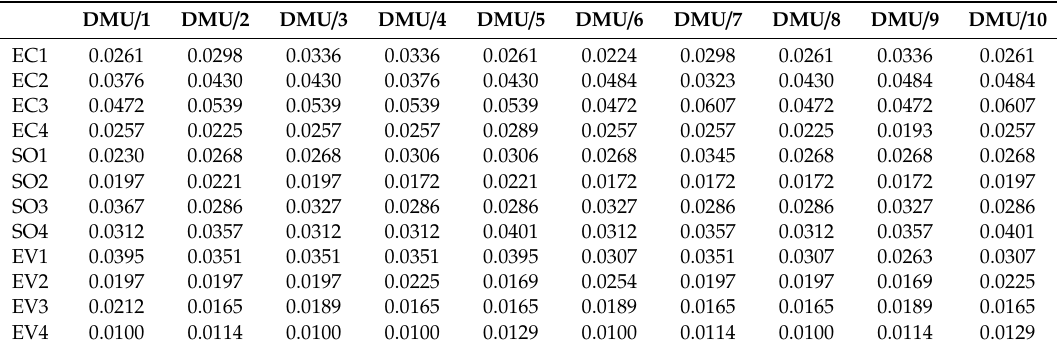
Table 8. Normalized weight matrix.